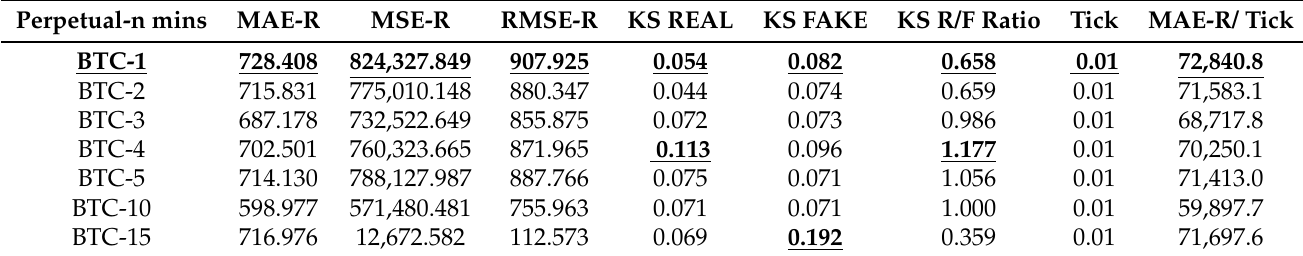
Table 16. We compared BTCUSDT perpetual prices at multiple time intervals. BTCUSDT at one minute interval has the highest MAE-R scores. The smallest KS REAL and KS FAKE are 0.044, and 0.071. The highest KS REAL and KS FAKE are 0.113 and 0.192, respectively.